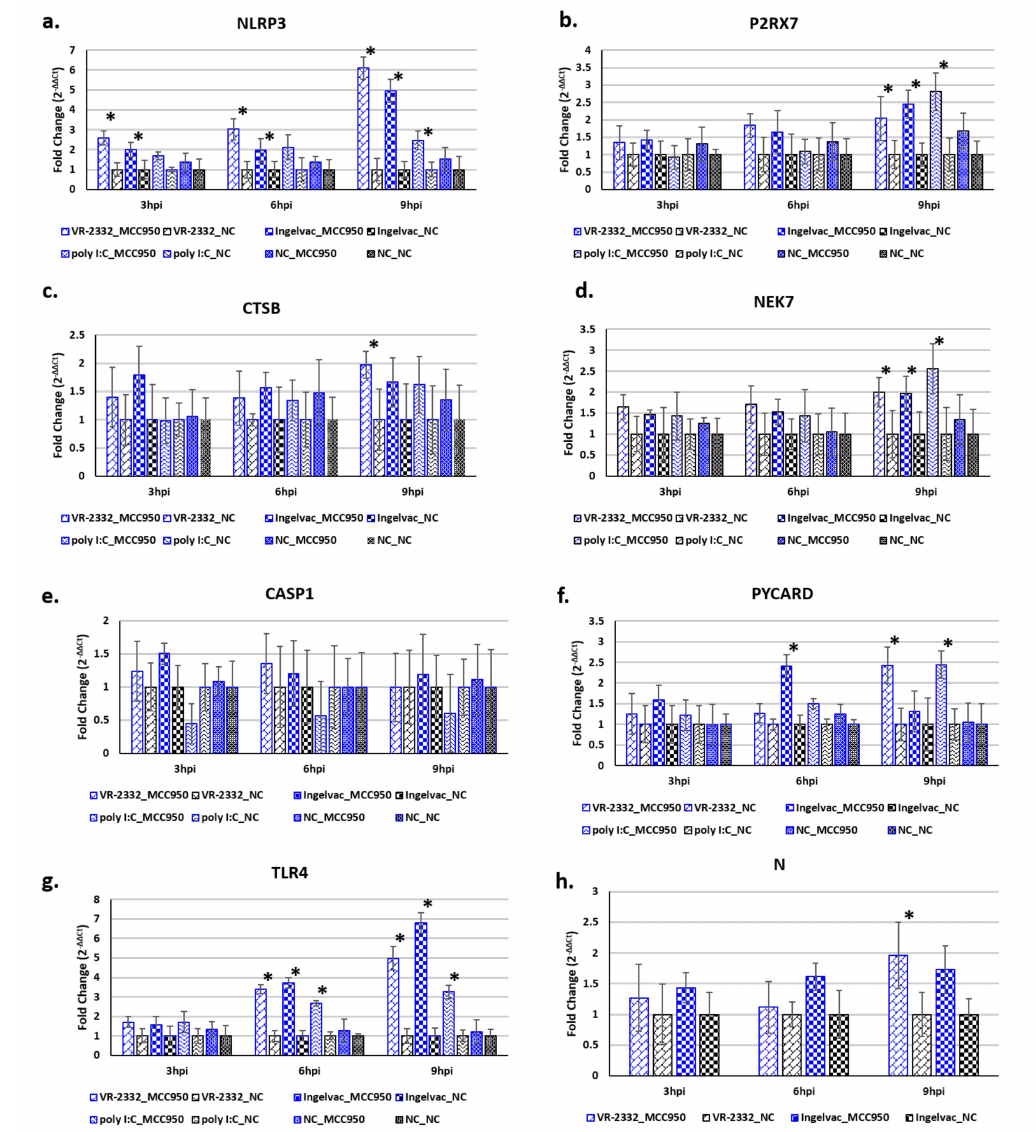
Figure 8. Inhibition of NLRP3 inflammasome activity in alveolar macrophages is beneficial to PRRSV replication. PAMs ( n = 3) were treated with the NLRP3 inflammasome inhibitor MCC950 at a final concentration of 10 µ M or mock-treated. One-hour post-treatment PAMs were either infected with VR-2332 (M.O.I. 1), Ingelvac MLV (M.O.I. 1), transfected with 1 µ g of poly I:C (known NLRP3 inflammasome activator) or mock infected. Expression levels of NLRP3 inflammasome-associated cellular genes ( a – g ) and PRRSV RNA levels ( h ) were assayed at 3, 6, and 9 hpi using RT-qPCR. Values are provided as fold di ff erences in gene expression levels between time-matched, MCC950-treated PAMs and mock-treated PAMs with same viral / poly I:C treatment, error bars denote SD for each group. * significantly ( p < 0.05) di ff erent expression levels between time-matched, MCC950-treated PAMs and mock-treated PAMs with same viral / poly I:C treatment. VR-2332_MCC950: PAMs treated with 10 µ M MCC950 for 1h then infected with VR-2332 (M.O.I. 1). VR-2332_NC: Mock-treated PAMs infected with VR-2332 (M.O.I. 1). Ingelvac MLV_MCC950: PAMs treated with 10 µ M MCC950 for 1 h then infected with Ingelvac MLV (M.O.I. 1). Ingelvac MLV_NC: Mock-treated PAMs infected with Ingelvac MLV (M.O.I. 1). poly I:C_MCC950: PAMs treated with 10 µ M MCC950 for 1 h then transfected with poly I:C (1 µ g). poly I:C_NC: Mock-treated PAMs transfected with poly I:C (1 µ g). NC_NC: Mock-treated, mock-infected